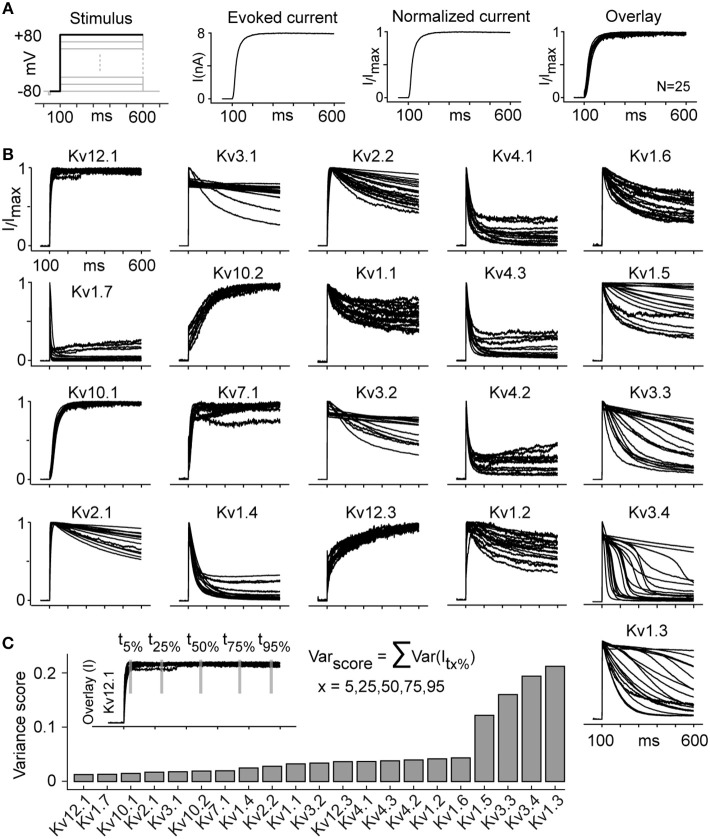
Kv channels kinetic heterogeneity (see also Figure S11). (A) The evoked current trace corresponding to the activation stimulus at +80 mV is normalized to maximum current for each cell. The overlay plot presents the normalized currents from 25 cells that statistically represent the whole group (same variance). (B) Overlay plots as described in panel A are shown for all active channels at 25°C (Kv11.1 and Kv11.3 are not included due to low current and high noise). The overlay plots visually represent the kinetic heterogeneity. (C) Kinetic heterogeneity is quantified by calculating Varscore, obtained by summing five variances of normalized currents evaluated at five time points for all cells of a given cell line, as shown for Kv12.1 as an example. The channels that show the highest heterogeneity (highest Varscore) are Kv1.3, Kv1.5, Kv3.3, and Kv3.4. The number of cells (N) for each group is listed in Table S5.